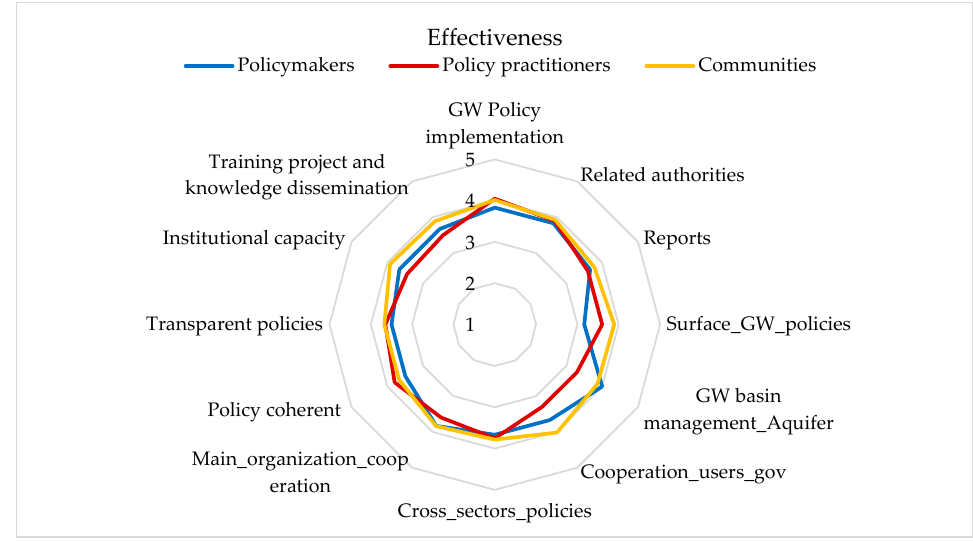
Figure 5. Effectiveness dimension of groundwater governance.